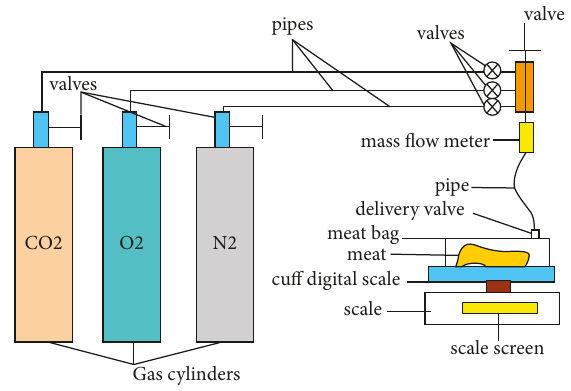
Figure 1: MAP system for CTMP at